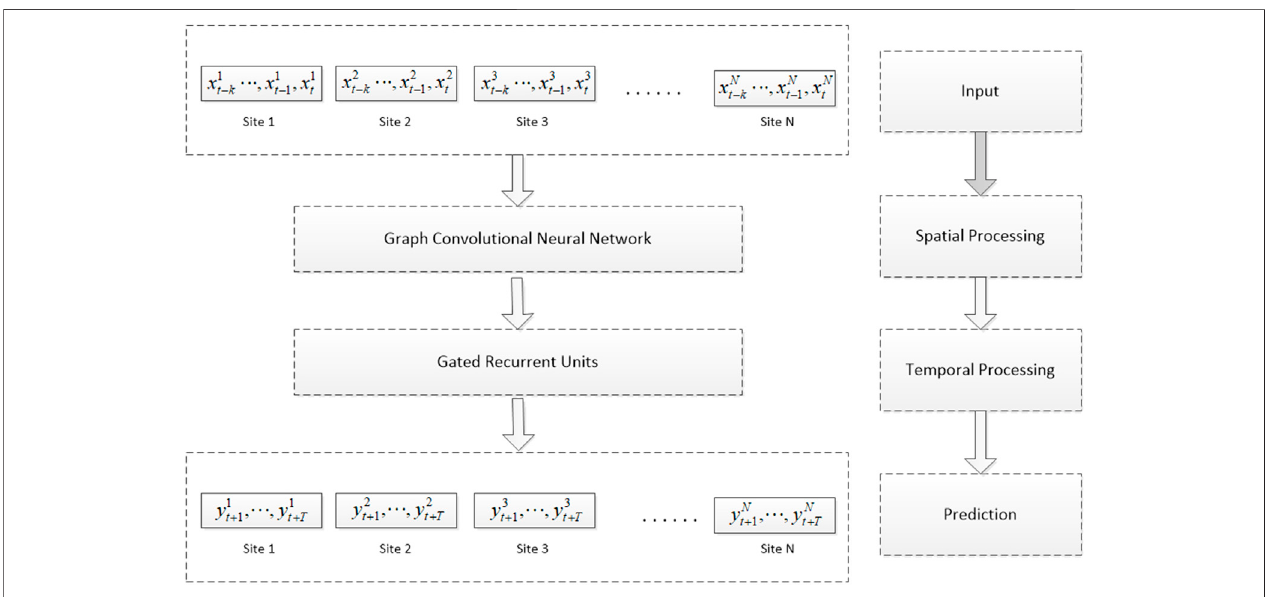
FIGURE 2 | Flow chart of the GCN-GRU